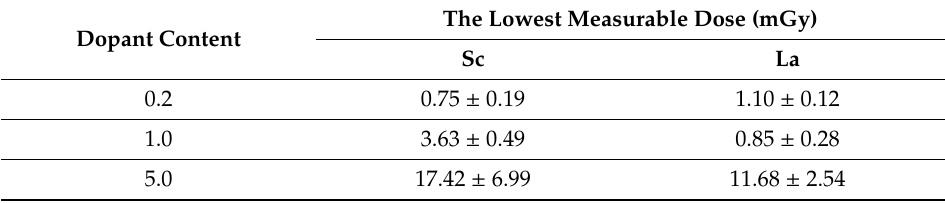
Table 1. The lowest measurable dose values evaluated for the studied YAP crystal samples doped with Sc and